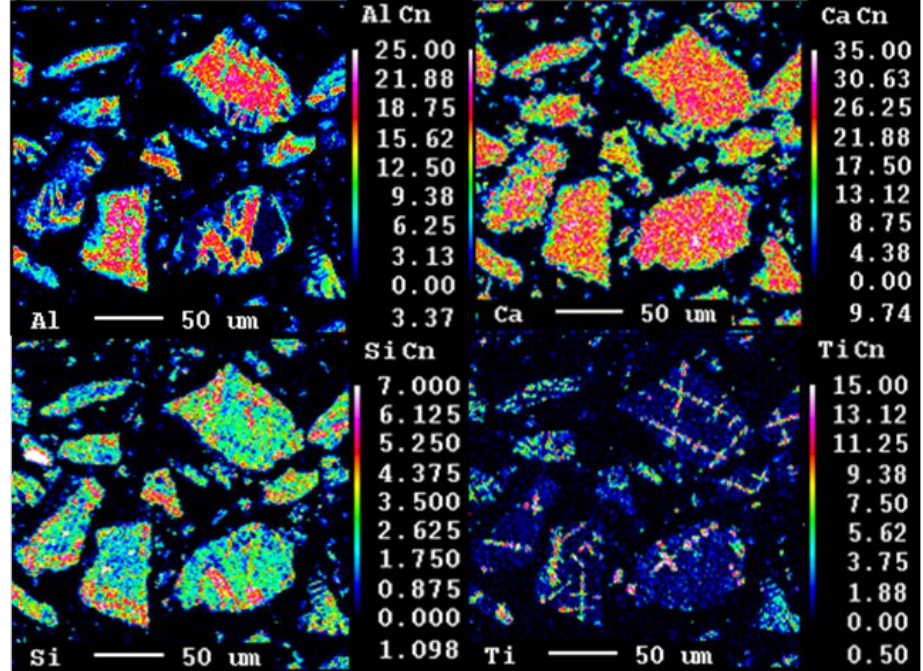
Figure 11 . Elemental mapping of grey mud from test no. 1 . Figure 11. Elemental mapping of grey mud from test no.